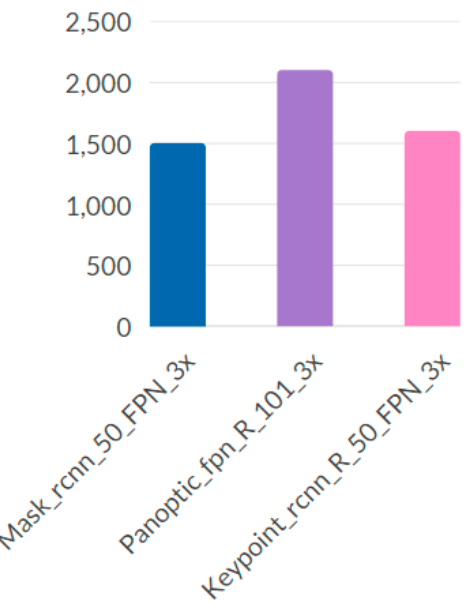
Figure 9. Result of the first experiment weight file for the false-positive tests.